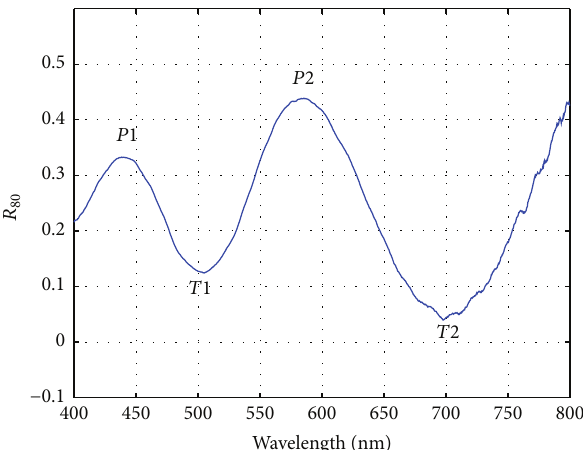
Figure 1: A typical AS spectrum has two major peaks and two major